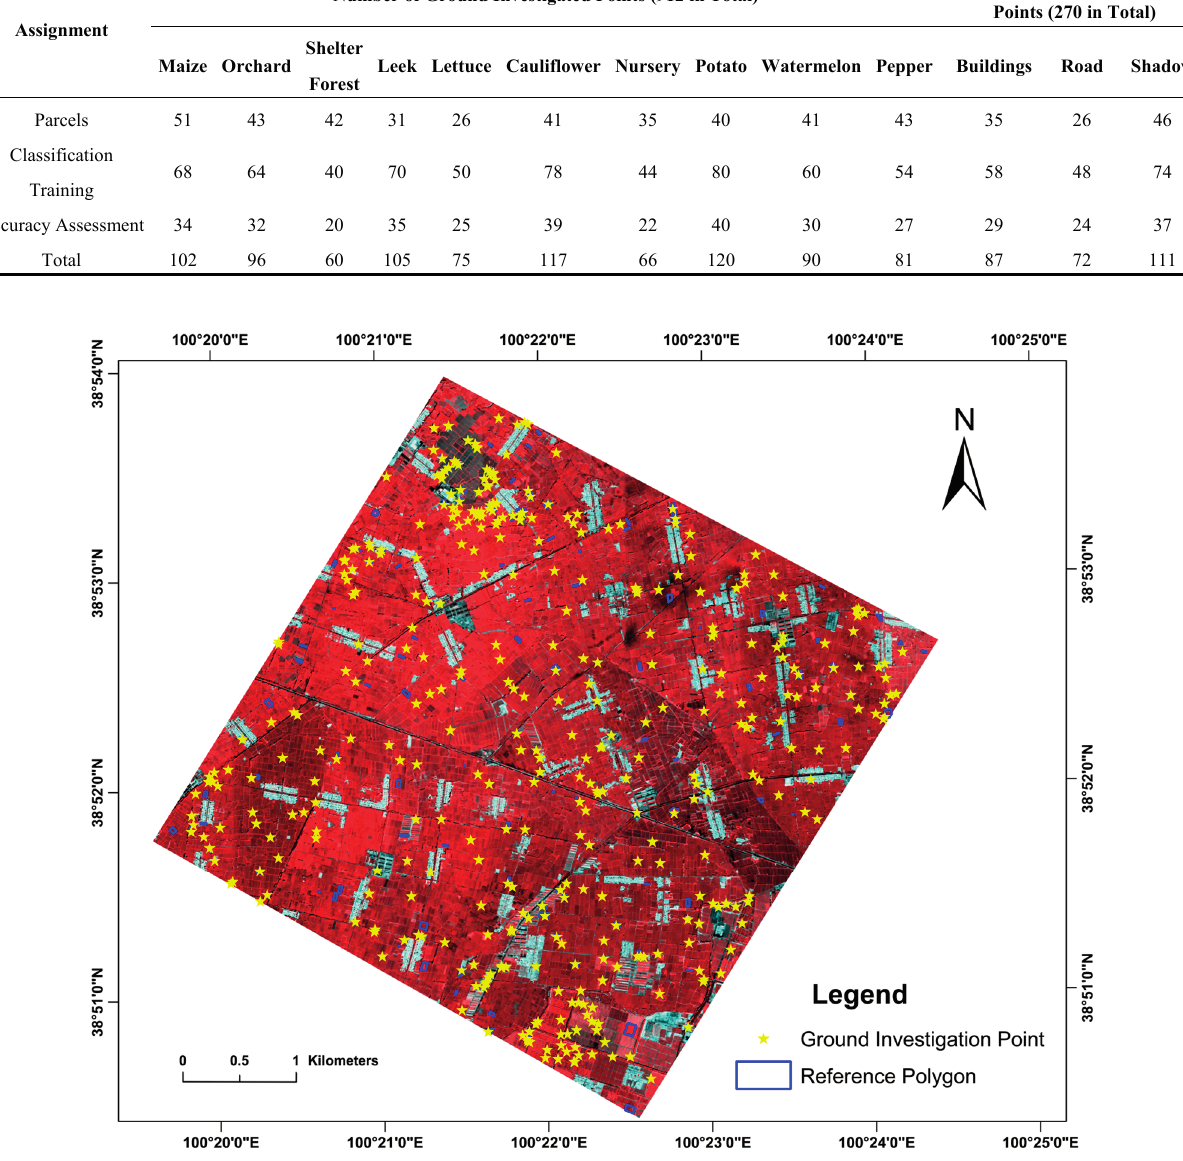
Figure 2. Locations of field survey parcels and reference objects that were used in our study. The yellow stars are the locations of field survey parcels. The blue polygons are reference objects for image segmentation accuracy